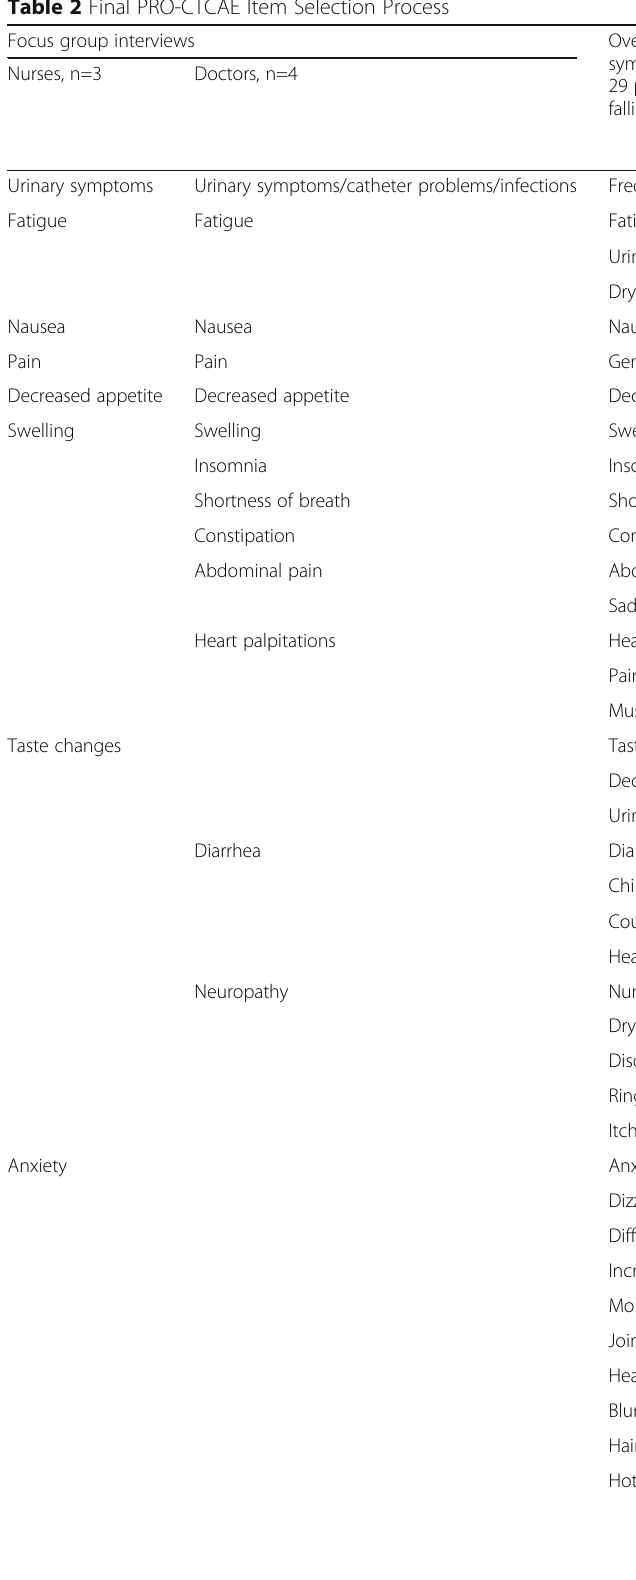
Table 2 Final PRO-CTCAE Item Selection